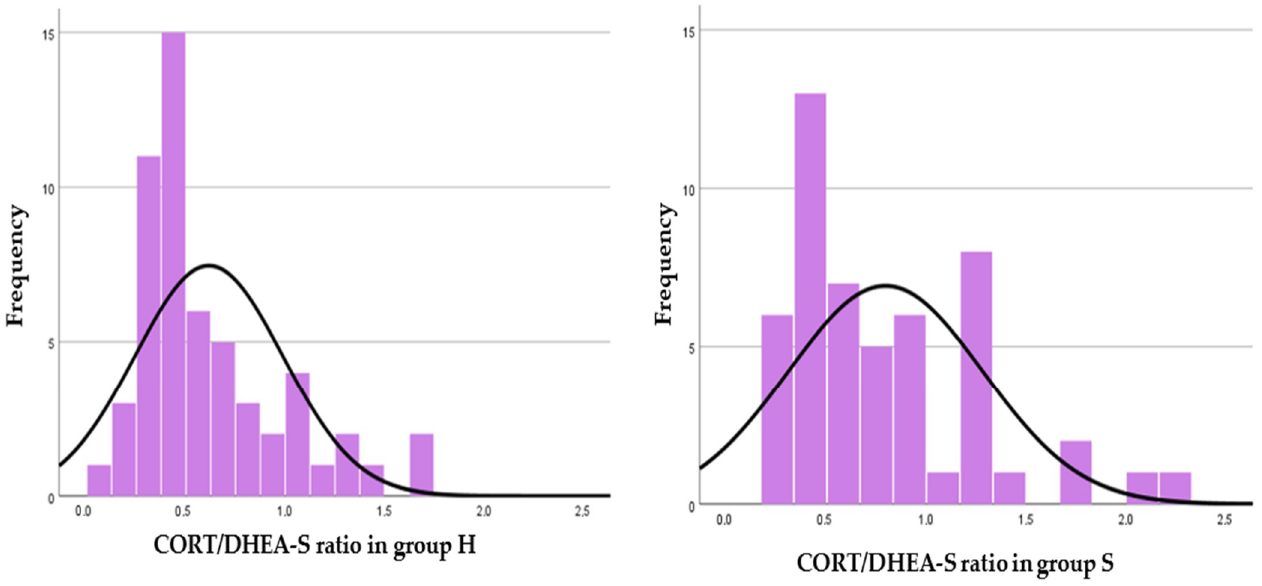
Figure 2. Frequency distribution graphs representing CORT/DHEA-S ratio in mares of the two groups (healthy foals—H, left; sick foals—S, right).